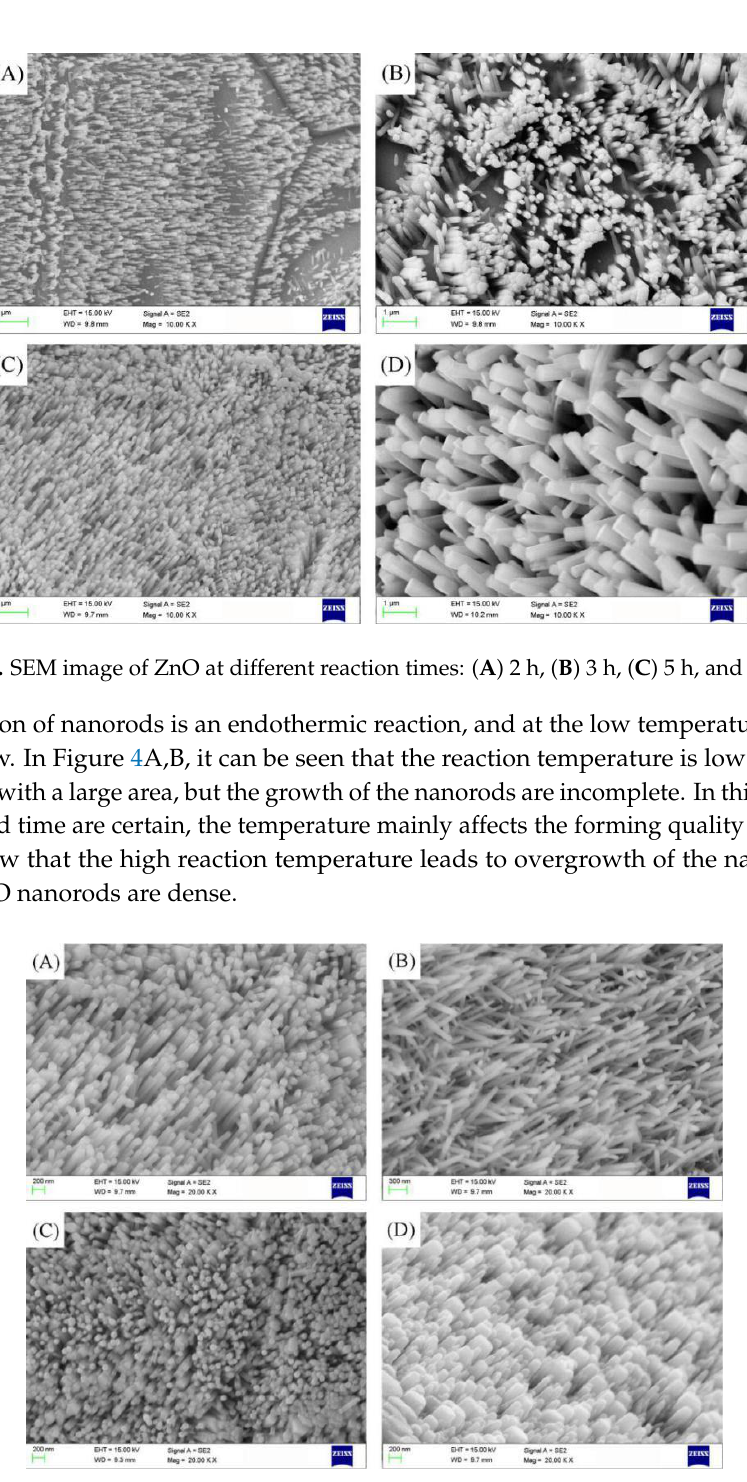
Figure 4. SEM image of ZnO at different reaction temperatures: ( A ) 75 °C, ( B ) 95 °C, ( C ) 105 °C, and ( D ) 115 °C.